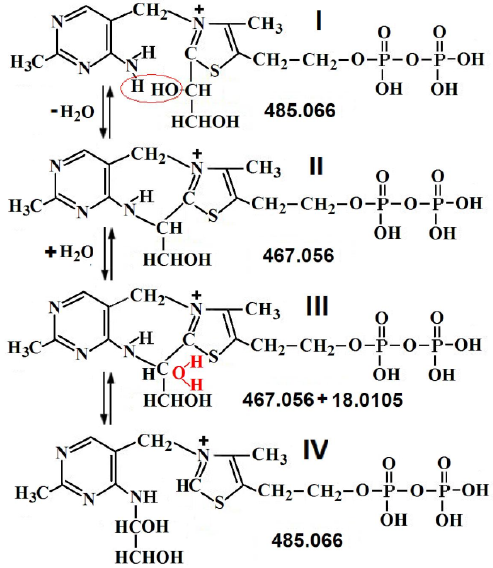
Figure 6. Proposed mechanism of the first stage of the one-substrate transketolase reaction.